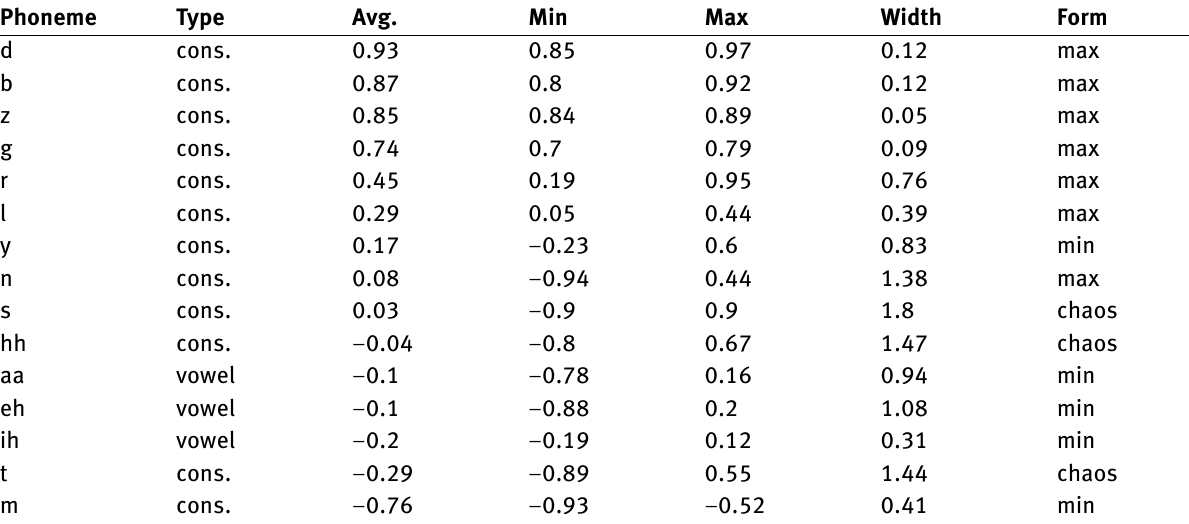
Table 2: The TAC coefficients for various phonemes (Cons. - consonant, Width - bandwidth). Phoneme